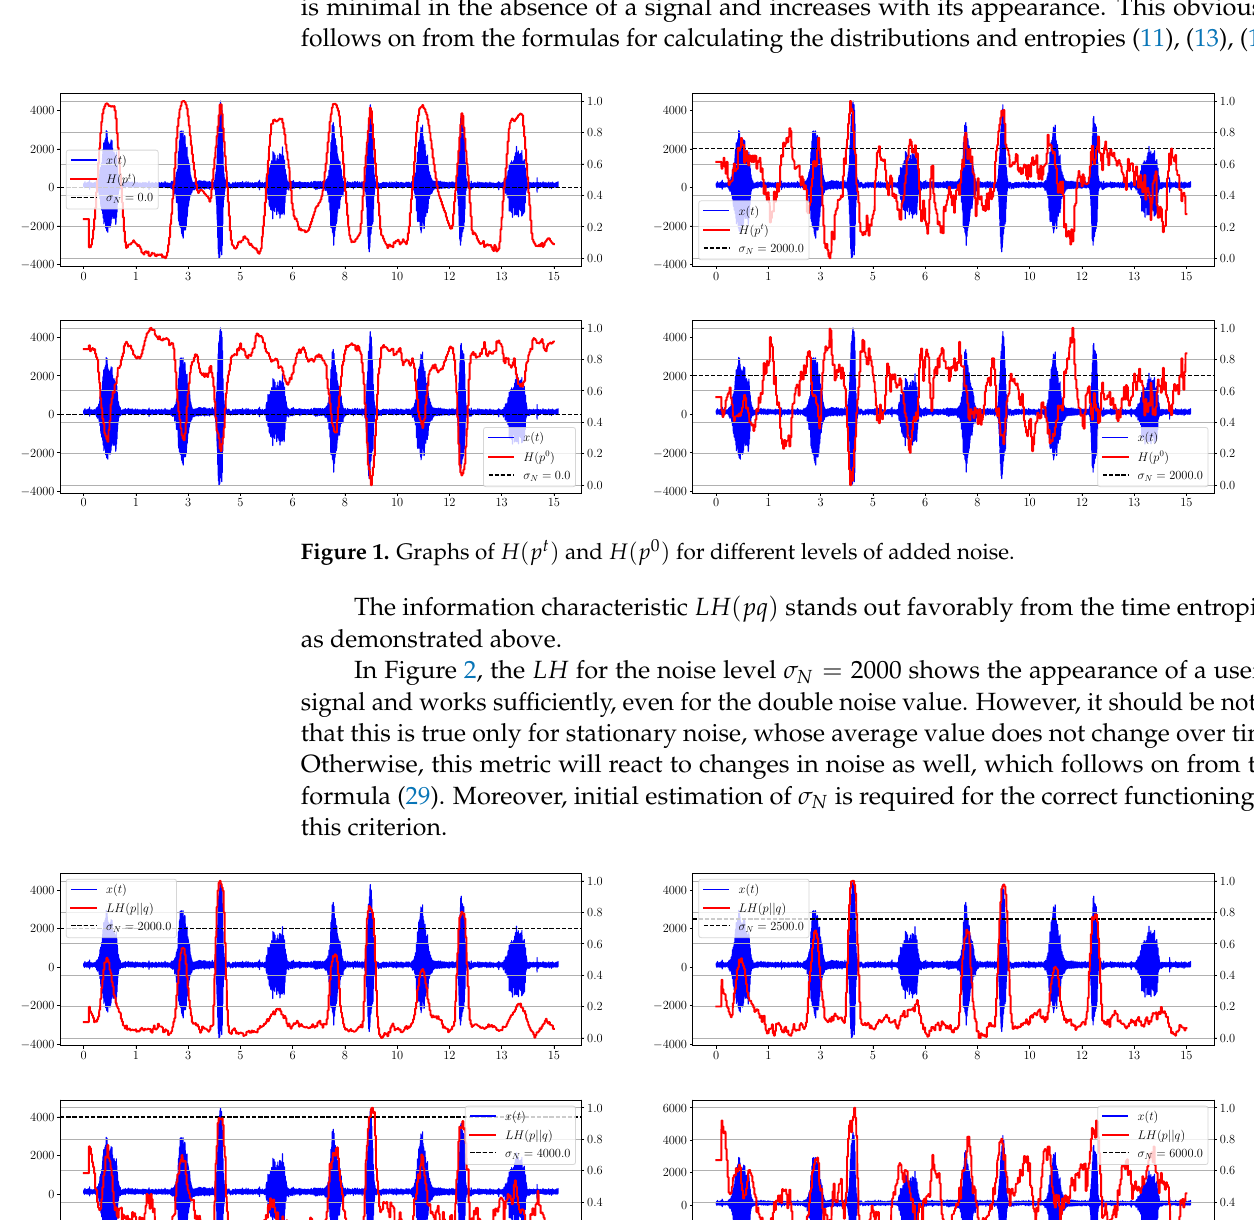
The time entropy H ( p 1 ) associated with another grouping of the ”alphabet” derived from the signal samples is considered separately and the graphs for different number of letters are shown in Figures 3 and